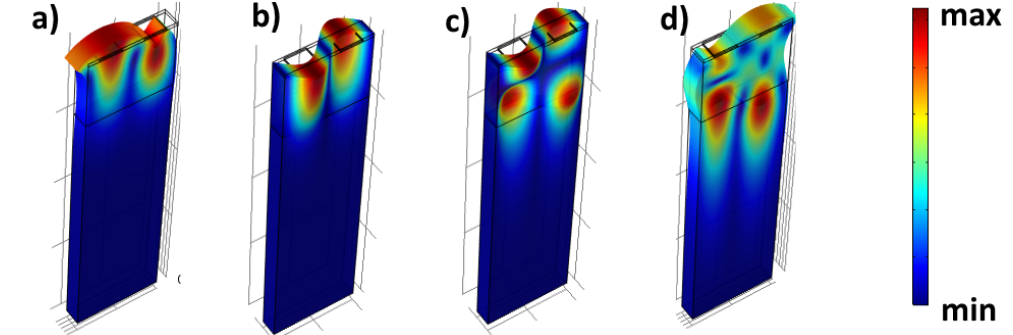
Figure 3. Eigenmode of surface waves in GaN/Sapphire of point ( a ) A , ( b ) B , ( c ) C and ( d ) D in Figure 2b.